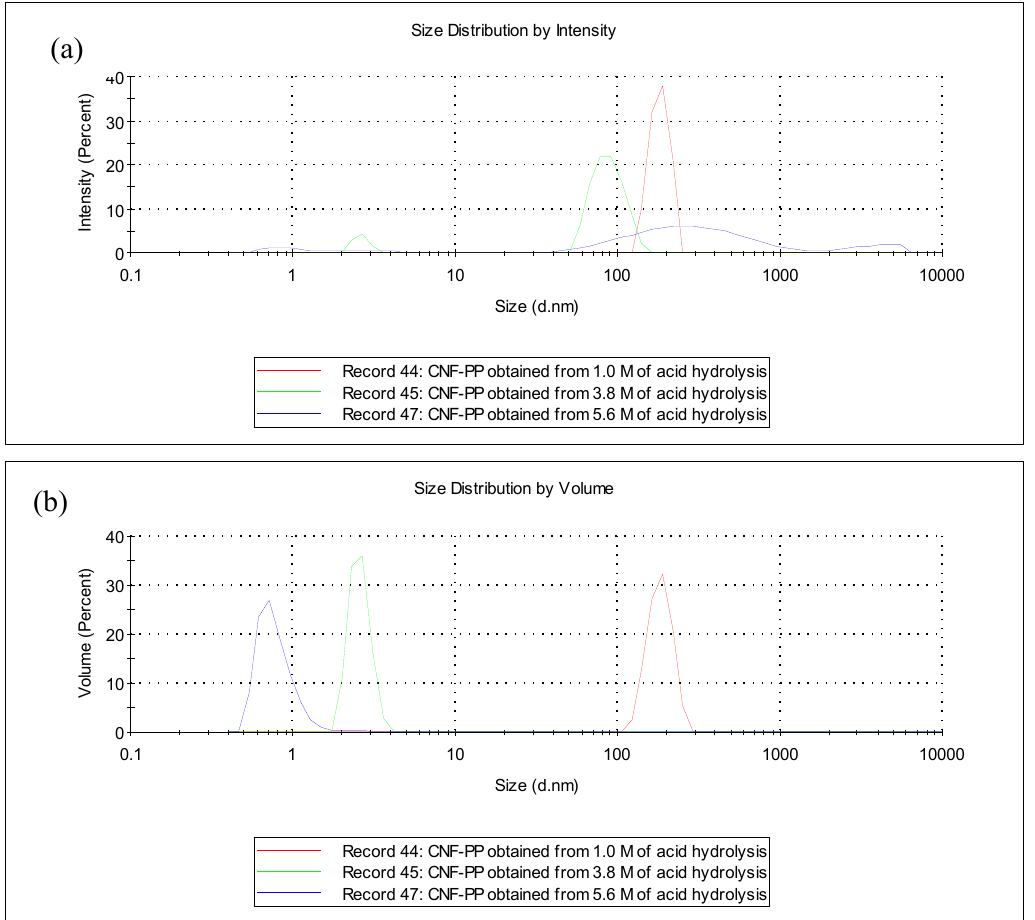
Figure 2. Particle size distribution by particle size analysis (PSA) ( a ) intensity-weighted distribution and ( b ) volume-weighted distribution of CNF-PP 1.0M , CNF-PP 3.8M and CNF-PP 5.6M .